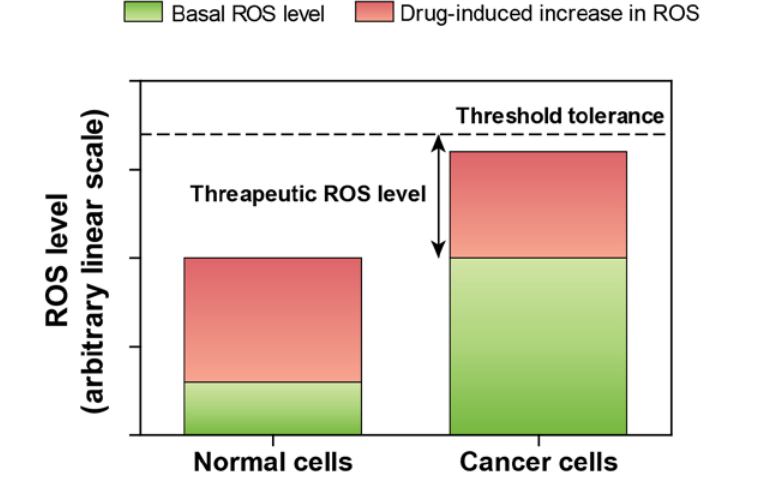
Figure 1. Effect of elevated level of ROS in normal and cancer